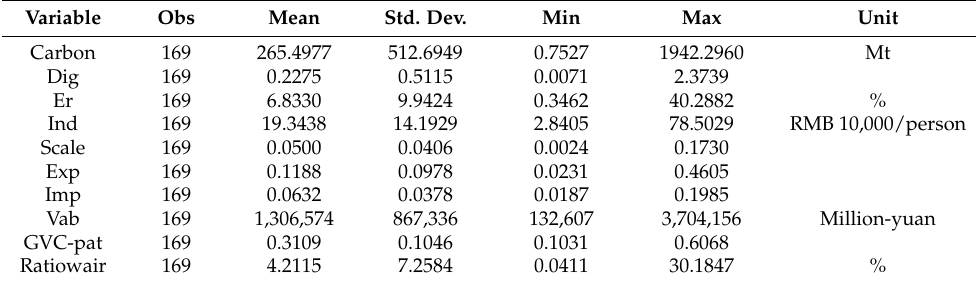
Table 3. Descriptive statistics of